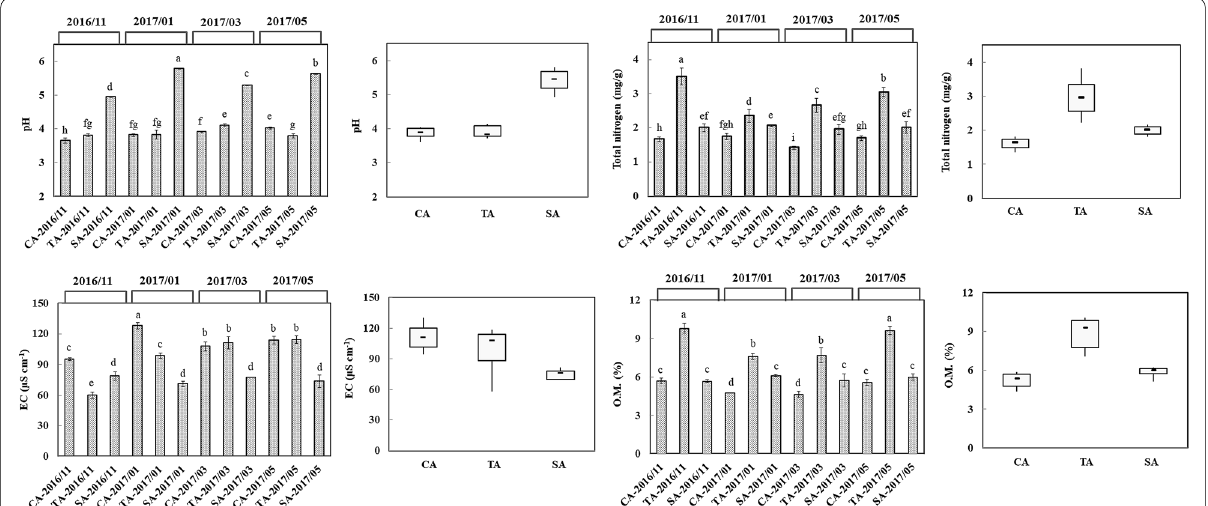
Fig. 1 Soil pH, EC, total nitrogen, and organic matter of tea plantations. These parameters were determined from CA, TA, and SA soils between November 2016 and May 2017. Results are shown as mean standard deviation. The different letters labeled at columns are significantly different ± according to Duncan’s test (p <